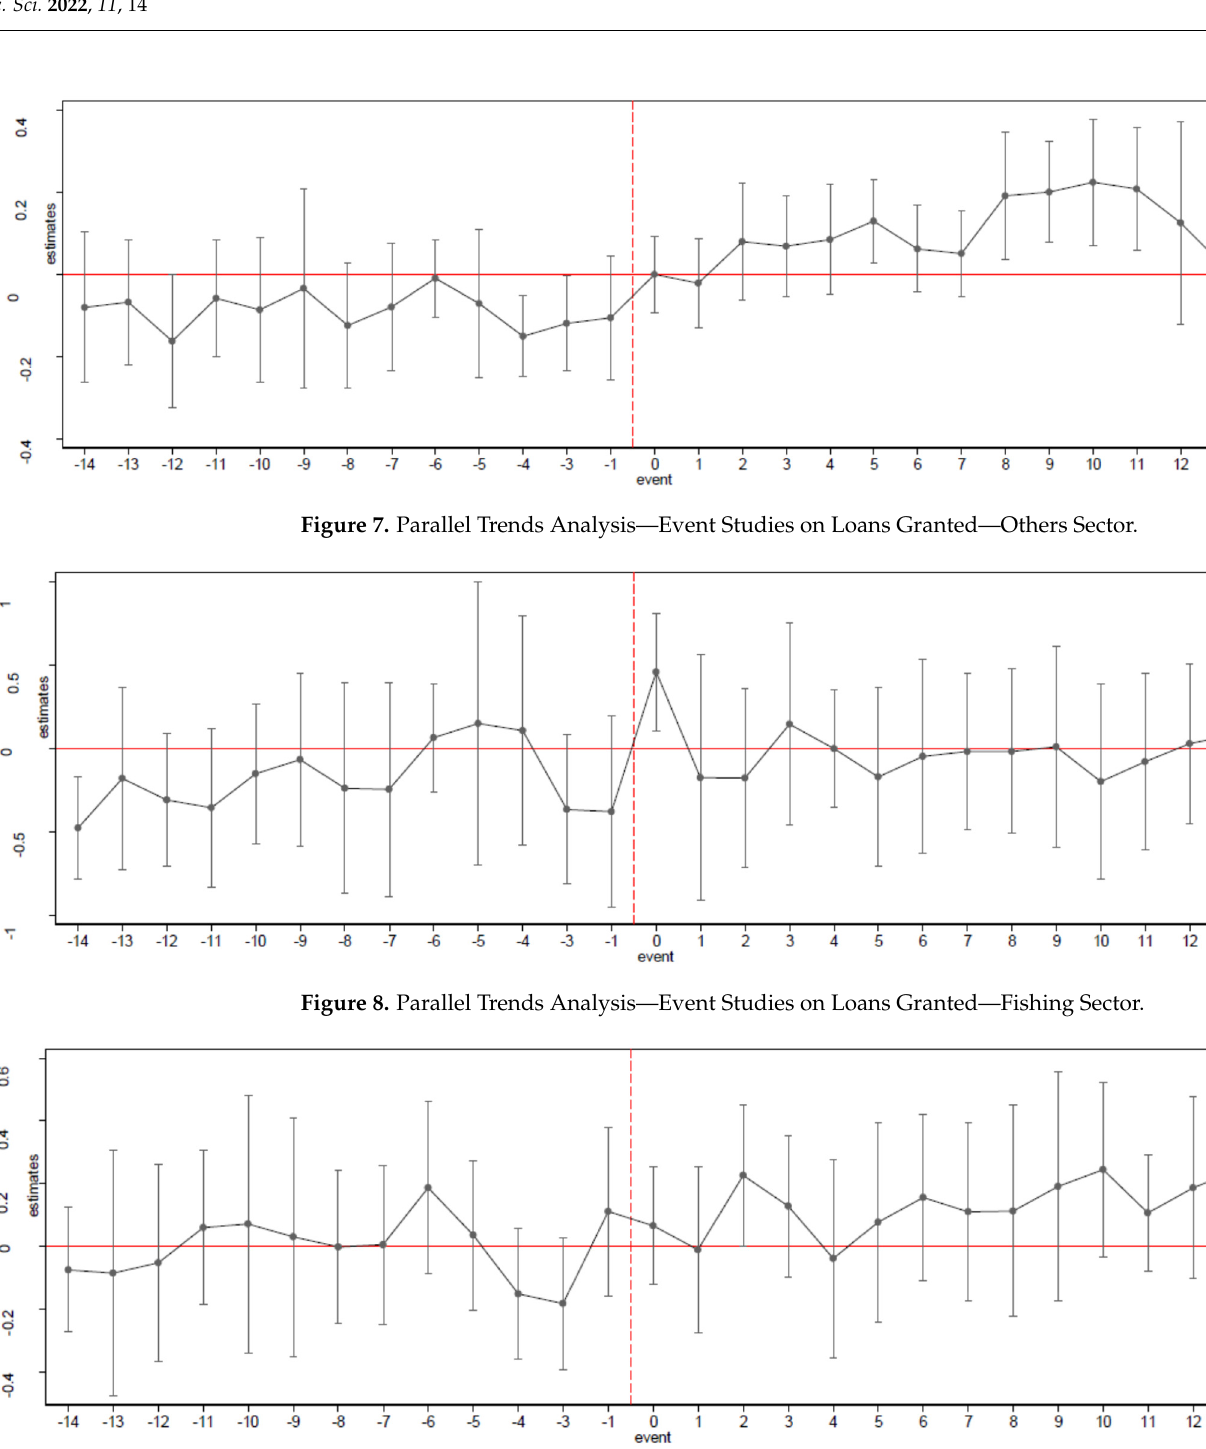
13 of 17 Figure 5. Parallel Trends Analysis—Event Studies on Loans Granted—Agricultural Sector.